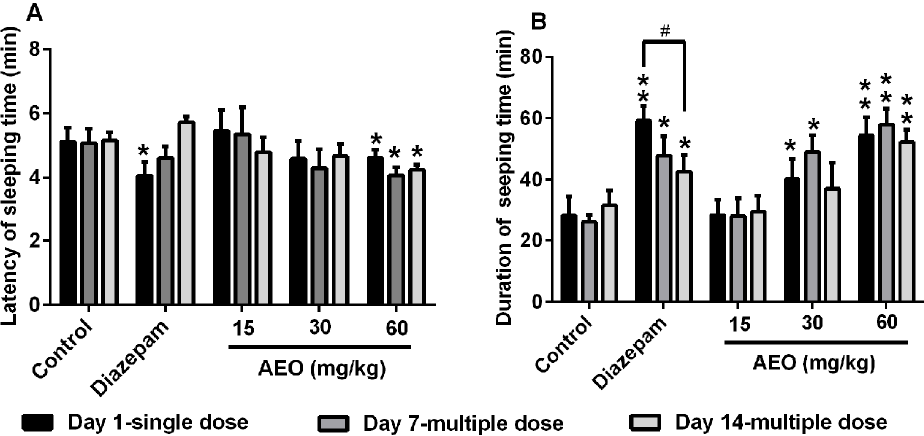
Figure 4. Effect of AEO on the hypnotic dose of pentobarbital-induced sleeping: ( A ) latency of sleeping time and ( B ) duration of sleeping time were recorded. AEO (15, 30, and 60 mg/kg), diazepam (2 mg/kg), or saline was administrated i.p. 30 min before the pentobarbital sodium (50 mg/kg) i.p. injection. The results are presented as mean ± SEM with n = 12. * p < 0.05 and ** p < 0.01 vs. control group at the same time. # p < 0.05 vs. the corresponding group at the same dose.